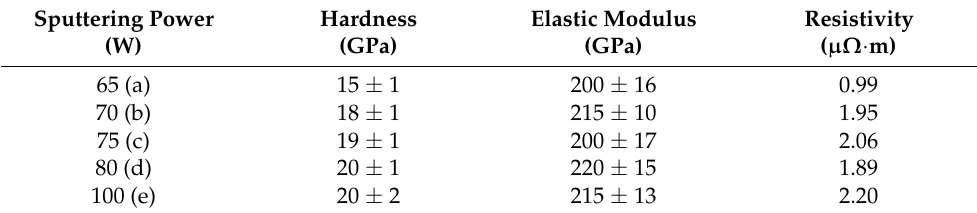
Table 4. Mechanical properties and electrical resistivity of the thin